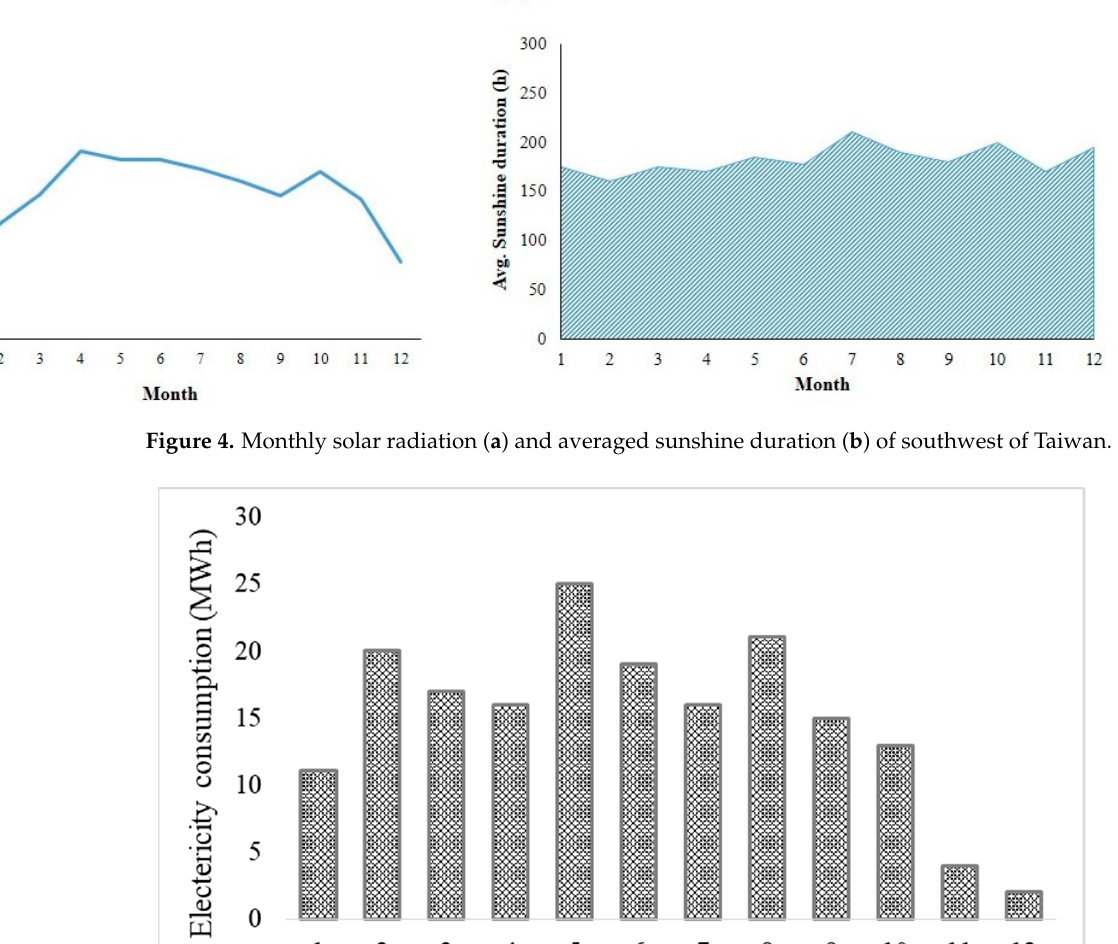
Figure 4. Monthly solar radiation ( a ) and averaged sunshine duration (b) of southwest of Taiwan.